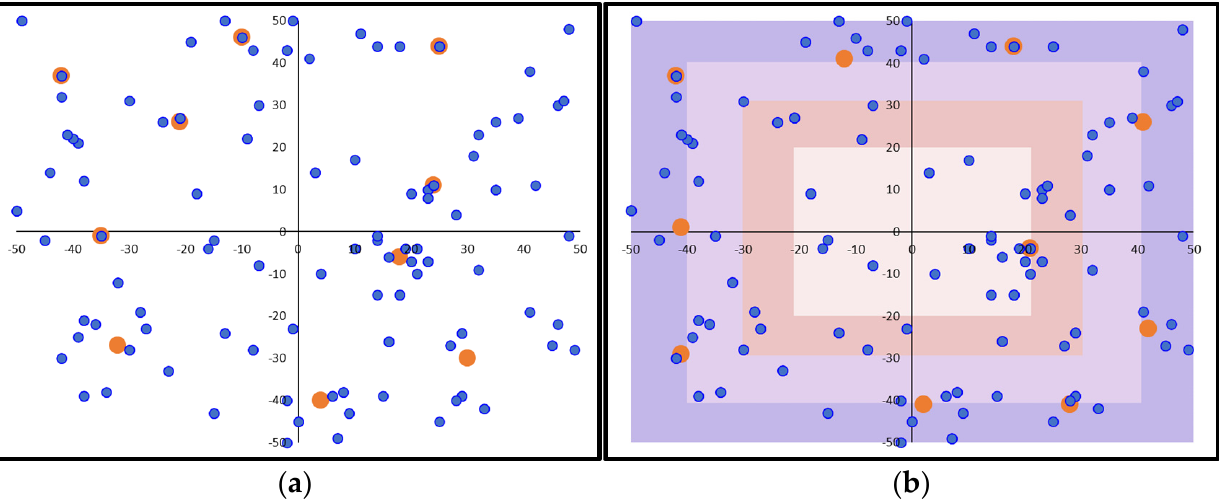
Figure 8. Optimal charging station deployment for 10 stations: ( a ) fixed station cost; ( b ) variable station cost (demand points in blue color, charging stations in orange color, highest cost zone in beige color, lowest cost zone in purple color).